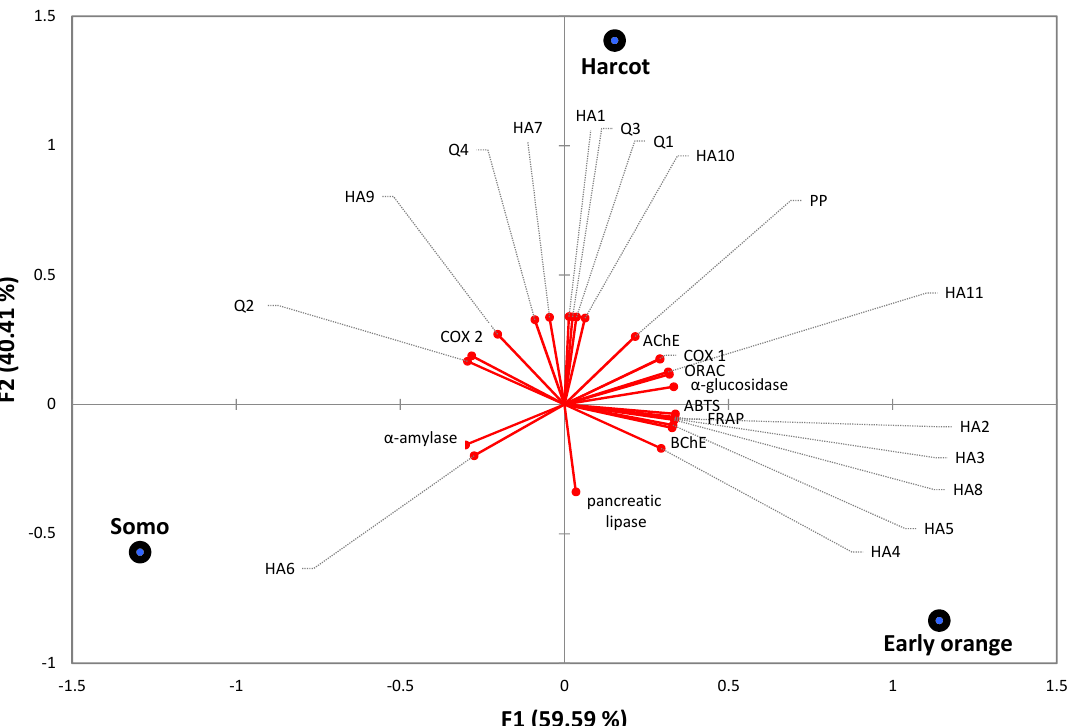
Figure 2. Biplot (PC1 × PC2) of scores and loadings for the PrALe, antioxidant capacity, and enzyme inhibitory. HA1- caffeoyl-glucoside; HA2-4- O -caffeoylquinic acid; HA3-3- p -coumaroyl-quinic acid; HA4-5- O -caffeoylquinic acid; HA5- p -coumaroyl-glucoside; HA6-3- O -feruloylquinic acid; HA7-feruloyl-glucoside; HA8- cis -5- O -caffeoylquinic acid; HA9-5- p -coumaroylo-quinic acid; HA10-4- O -feruloylquinic acid; Q1-quercetin-3- O -rutionoside; Q2-quercetin-3- O -rutinoside; Q3-quercetin-3- O -galactoside; Q4-keampferol-3- O -rutinoside; PP-polymeric procyanidins; ORAC-the Oxygen Radical Absorbance Capacity; AChE-acetylcholinesterase; BChE-butylcholinesterase; COX-cyclooxygenase.